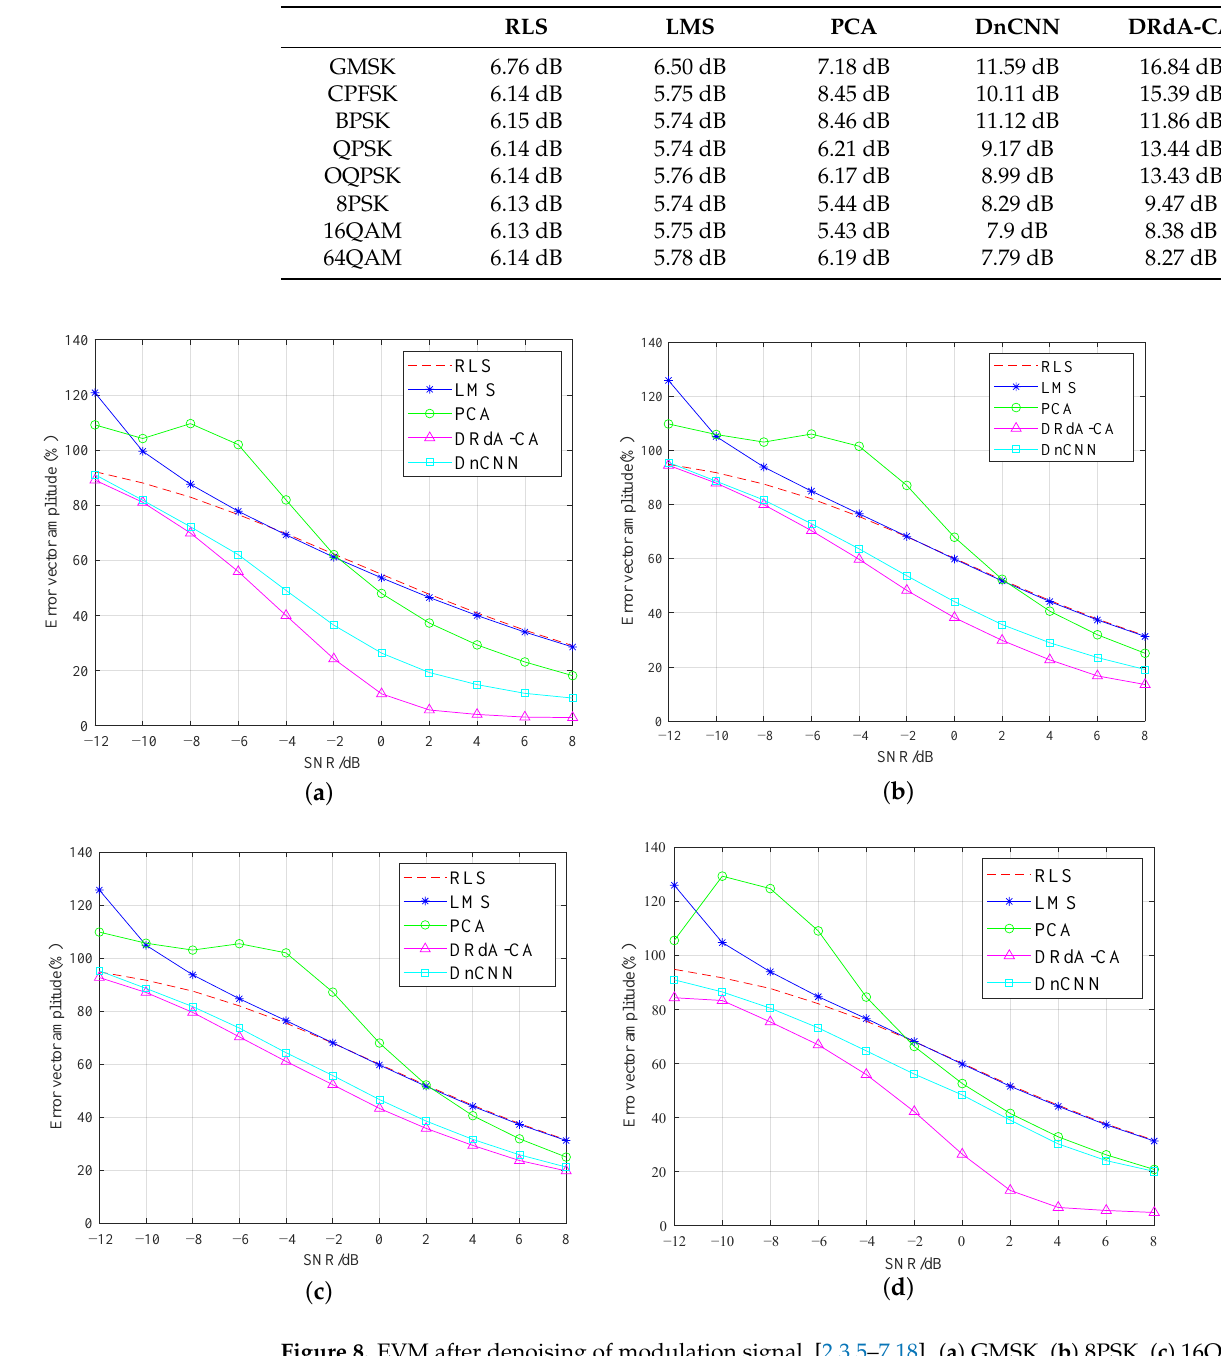
Figure 8. EVM after denoising of modulation signal [2,3,5–7,18]. ( a ) GMSK. ( b ) 8PSK. ( c ) 16QAM. ( d )